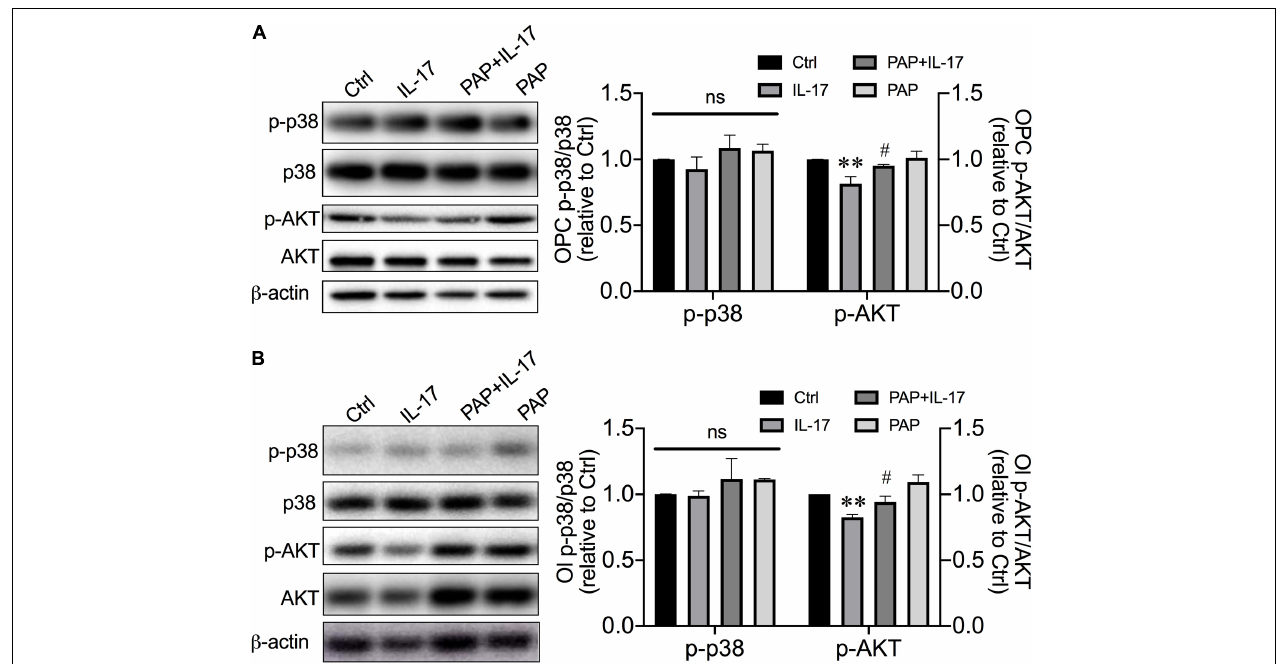
FIGURE 3 | Kv1.3 involved in IL-17–induced developmental alterations by diminishing AKT signal but not p38 MAPK. OPCs were treated as described in Figure 2 . (A) Representative images and statistical analyses of p-p38 and p-AKT expression in OPCs of Western blot ( n = 3). IL-17 suppressed the p-AKT expression, which represented the activation level of AKT pathway in OPCs, but not p-38, whereas PAP relieved this suppression. (B) For experiments conducted with Ols, OPCs were transferred into OPCDM and treated the same as described in Figure 2 . Representative images and band densitometry data (right) of p-p38 and p-AKT expression in Ols ( n = 4). The attenuation of p-AKT induced by IL-17 was mitigated by PAP, indicating the integral role of Kv1.3 in IL-17–caused decline of AKT activation. ∗∗ P < 0.01 vs. control, # P < 0.05 vs.